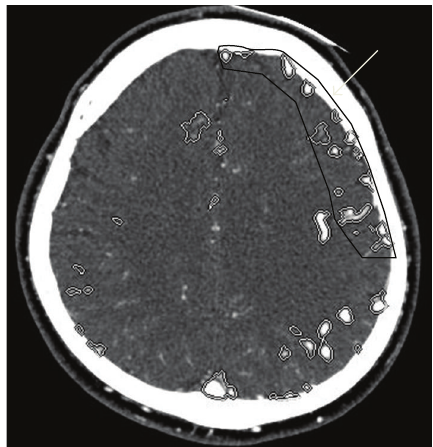
Figure 2: In a former axial image of 3D-CT angiography arterial phase obtained after admission, abnormal vessels (circle markings) appeared in the left cerebral hemisphere including the DLPFC